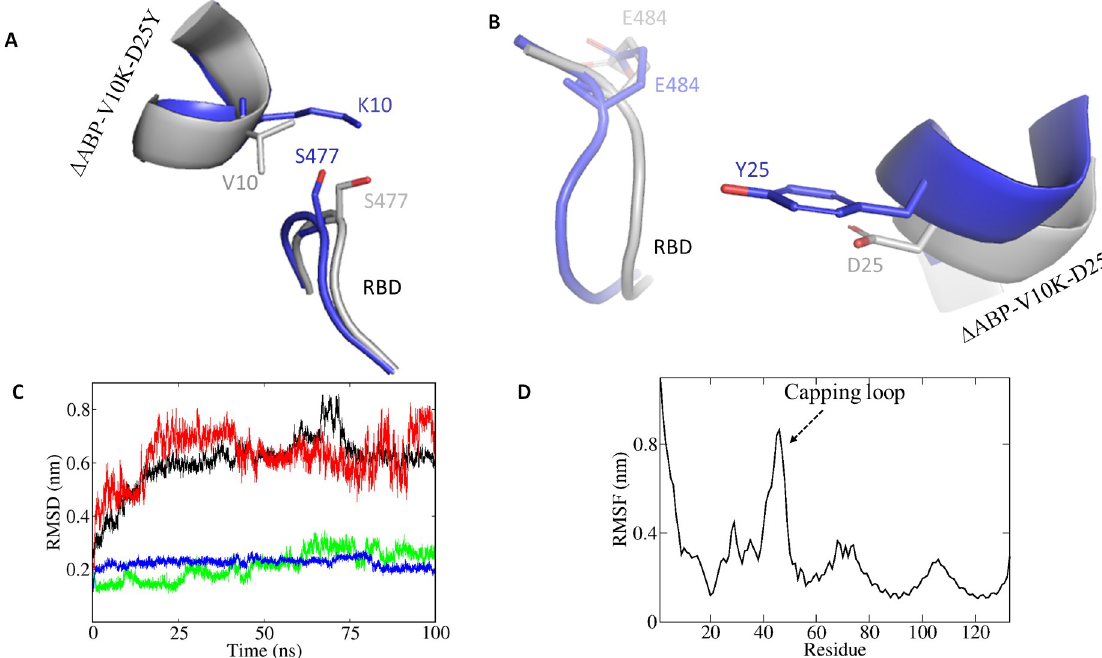
Fig 5. The mutant inhibitor interaction with RBD. A) Val10Lys mutation enables the peptide to interact with Ser477 of RBD. B) Asp25Tyr mutation interacts with Glu484. C) RMSD curves of SARS-CoV-2 RBD and Δ ABP-D25Y complex (black), RBD capping loop (residues 472– 488; red), RBD interface (residues 489–499; green) and Δ ABP-D25Y interface (residues 17–34; blue) during the 100 ns simulation. D) Averaged root-mean-square fluctuation for each amino acid in SARS-CoV-2 RBD (denoted by residue 1–73) and Δ ABP-D25Y (denoted by residue 74–133) complex. Capping loop at RBM site is highly